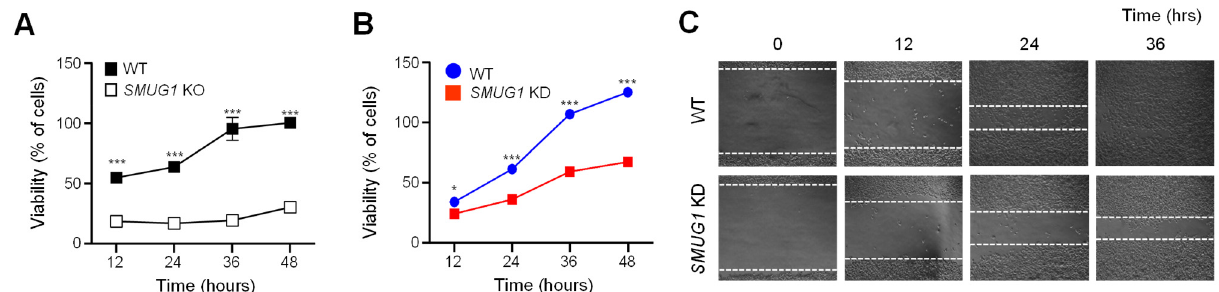
Figure 2. Ablation of SMUG1 reduces the cell viability and proliferation ratio in hepatocarcinoma HepG2 cells. ( A ) Cell viability was measured by MTT assay from HepG2 WT and SMUG1 KO cells. ( B ) Cell proliferation was measured by MTT assay from HepG2 WT and SMUG1 KD cells. ( C ) Wound healing assay was performed in HepG2 WT and SMUG1 KO cells. Error bars show mean ± SEM . p values obtained by Student’s t -test. *** p value < 0.001, * p value < 0.05.